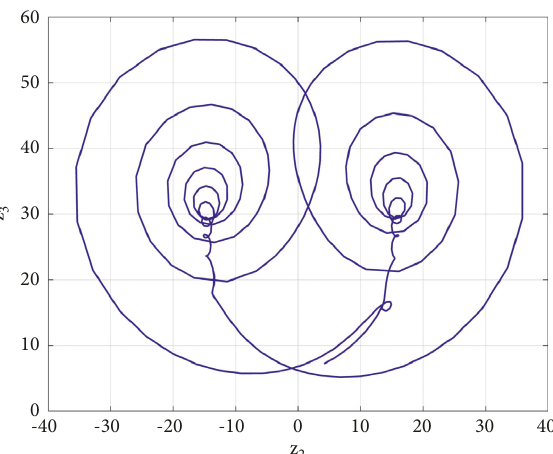
Figure 18: A hyperchaotic attractor of the model (1) for c � 50 and ( a, b,d ) � ( 25 , 8 , 6 ) .